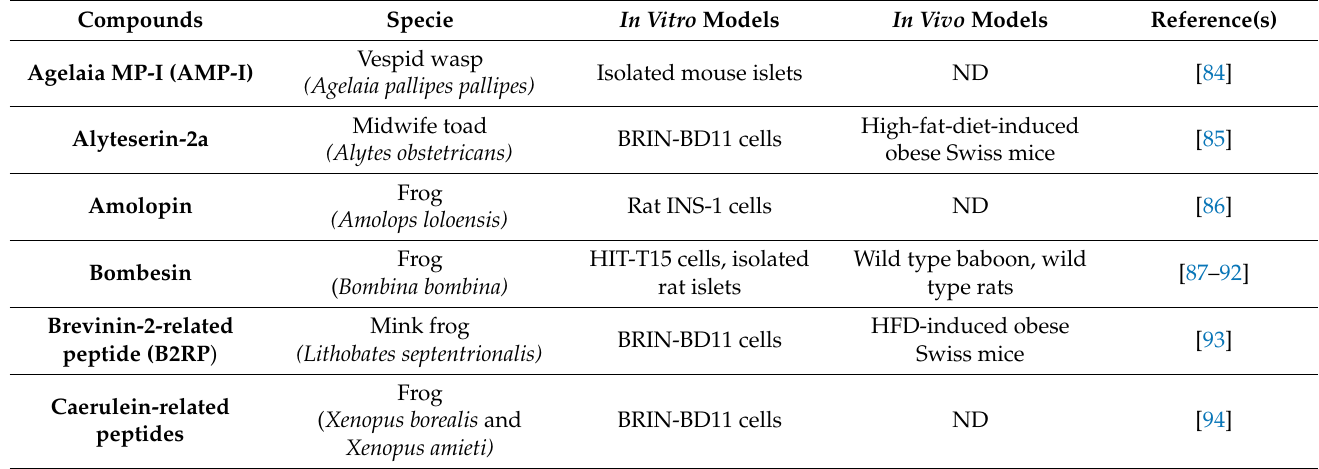
Table 3. Peptides stimulating insulin secretion with unknown